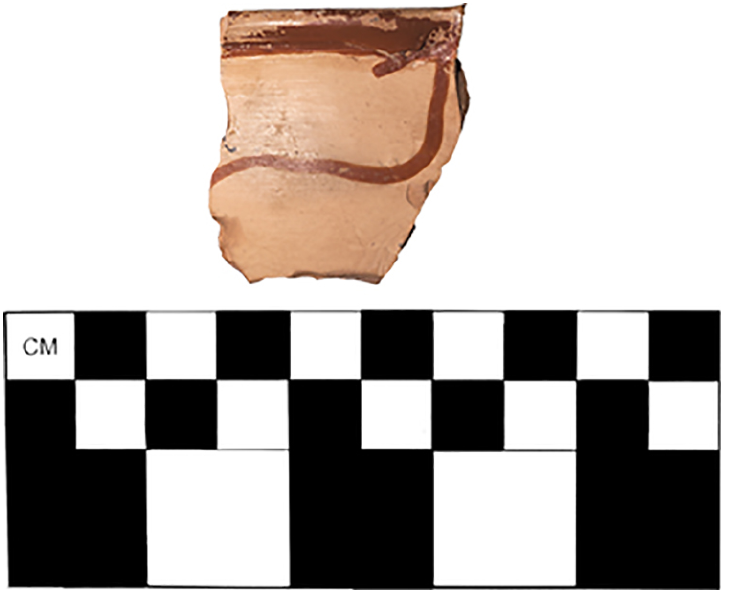
Figure 11. Photograph of Mycenaean Sherd recovered from the Double Chapel at Borġ in-Nadur. Photograph by Fred